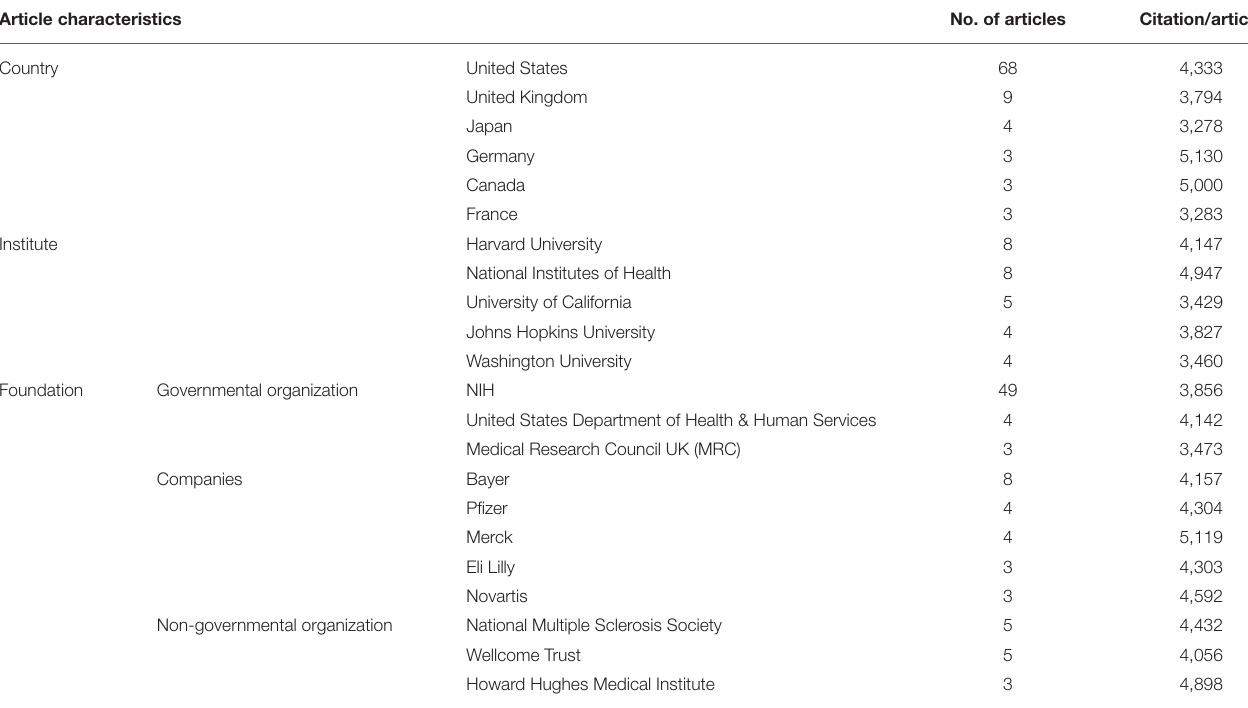
TABLE 1 | Country, institute, and foundation with multiple articles in the most-cited